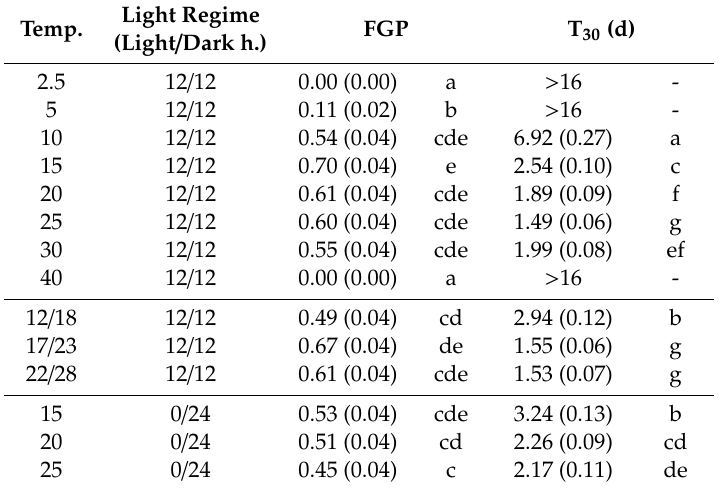
Table 1. Influence of temperature and light regime on maximum proportion of germinated seeds (FGP, Final Germination Proportion) and time to 30% germination (T 30 ) for C. canadensis. Standard errors are in parentheses. Temp.